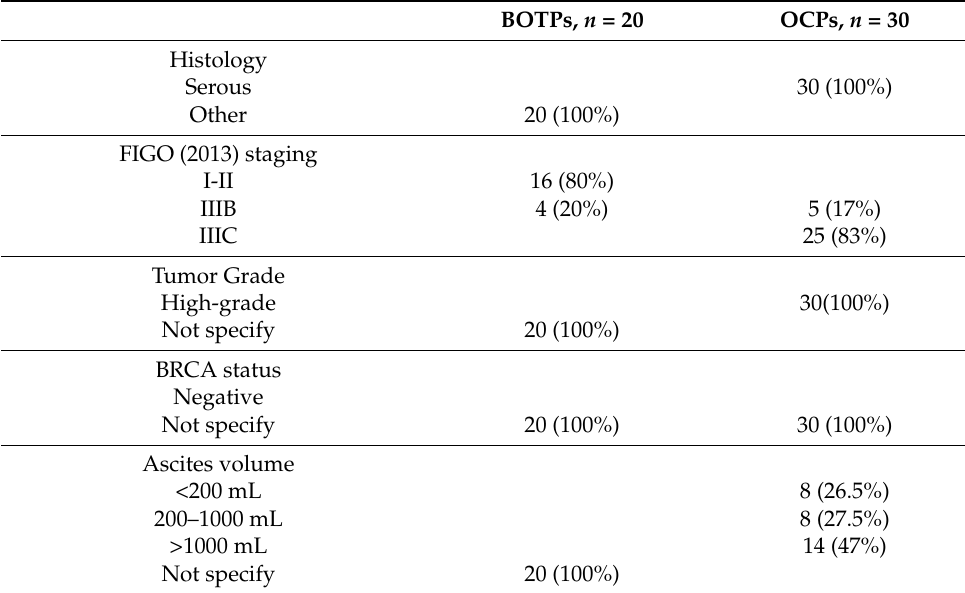
Table 8. General clinical characteristics of the BOTPs and the